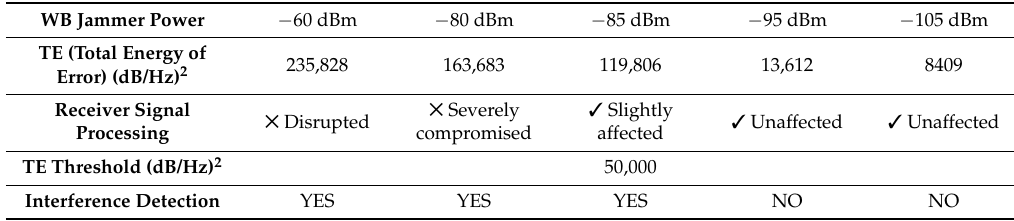
Table 3. Wideband interference: in-lab test